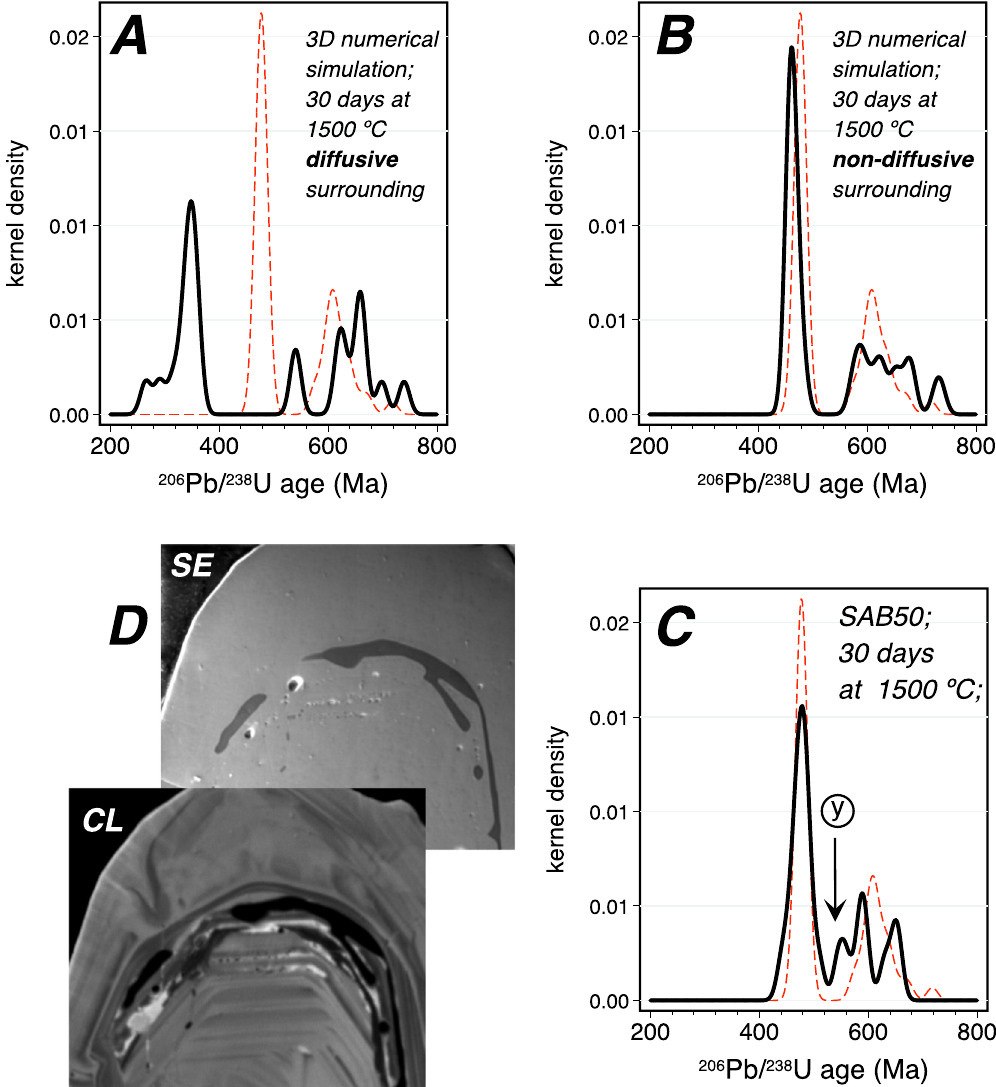
Figure 4. ( A and B ) Numerical simulation of diffusion in SAB50 at 1500 °C over 30 days in diffusive and non- diffusive surroundings. Note the huge displacement of the rims peak in the former. ( C ) Age distribution of the experimental run at 1500 °C for 30 days. The red dashed line represents the distribution of the pristine SAB50 zircon grains. Again, the experiment and the simulation with non-diffusive surrounding match well, except for the appearance of the peak “Y”, which correspond to analyses in the region of melt inclusions. ( D ) Secondary electron (SE) and cathodoluminescence (CL) images of a zircon grain with an accumulation of albitic glass at the interface between the Cambro-Ordovician rim and the Ediacaran core (see